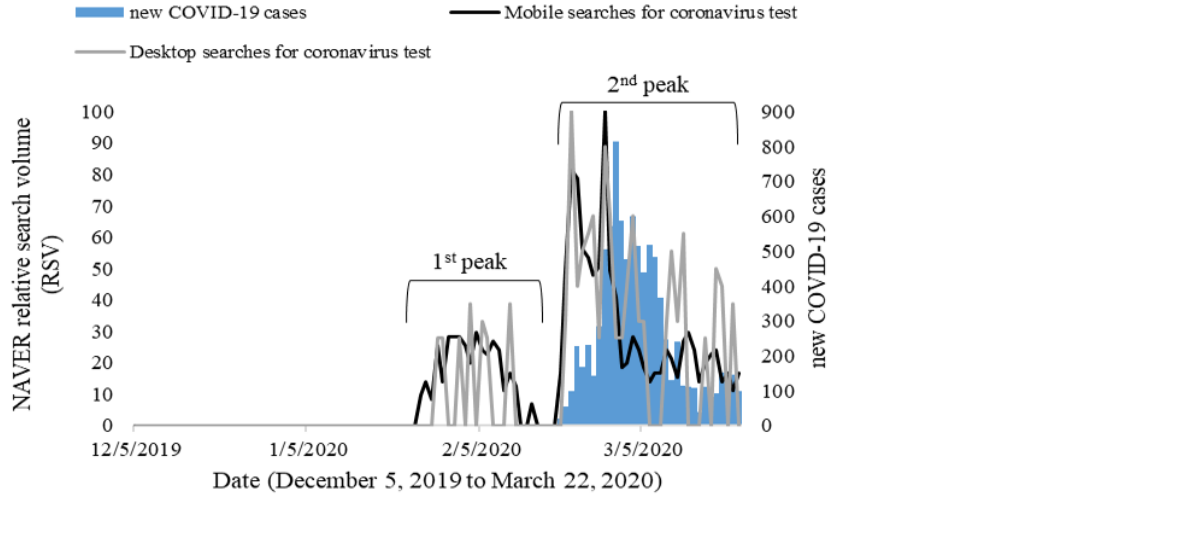
coronavirus-related searches through desktop devices. For coronavirus test online searches, strong correlations ( r =0.770-0.828) were reported for all lag and lead days. Still, mobile searches were observed to have a stronger correlation coefficient than desktop searches. The strongest correlations were found with a lag of 0 days for mobile searches ( r =0.804) and with a lag of 1 day for desktop searches ( r